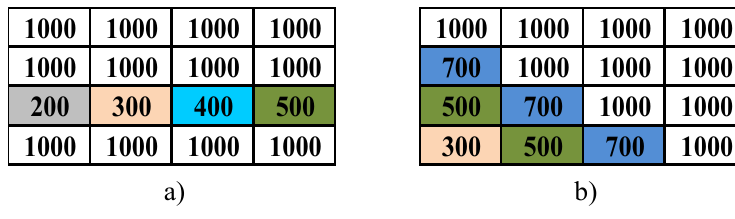
Figure 9. Experimental setup.